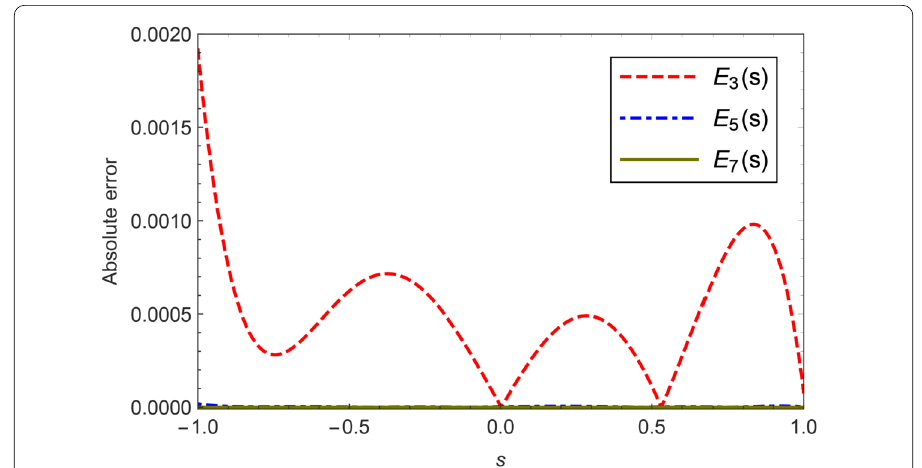
Figure 4 Absolute errors | E n ( s ) | for Example 2 with m = 16